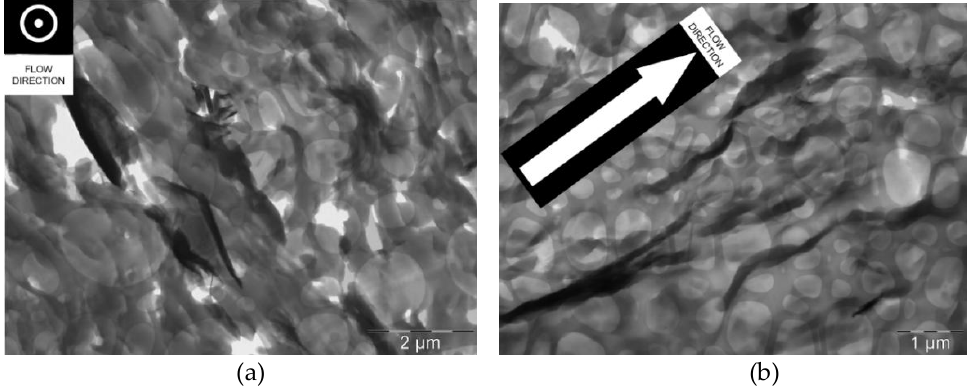
Figure 8. TEM micrograph of ABS/GNP nanocomposite filament: ( a ) Perpendicular and ( b ) parallel.